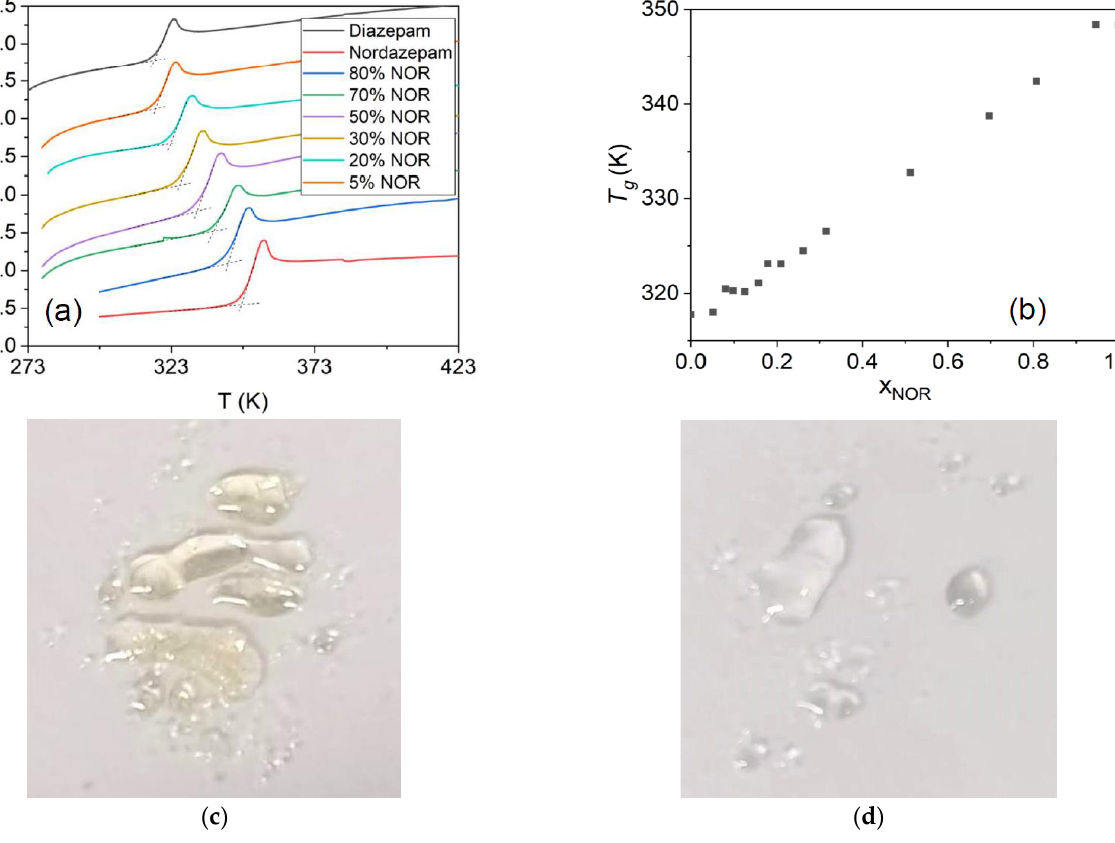
Figure 2. ( a ) Second heating DSC traces of DIA, NOR, and their binary mixtures at different molar fractions: only the glass-transition step is visible. ( b ) Glass-transition temperatures of DIA and NOR binary mixtures as a function of NOR molar fraction. ( c , d ) Room-temperature photographs of a droplet of glassy NOR melted just above T m,N ( c ), and of an eutectic droplet obtained by melting the x NOR = 0.18 mechanical mixtures to the eutectic melting point T e ( d ). The powders were melted directly on a glass